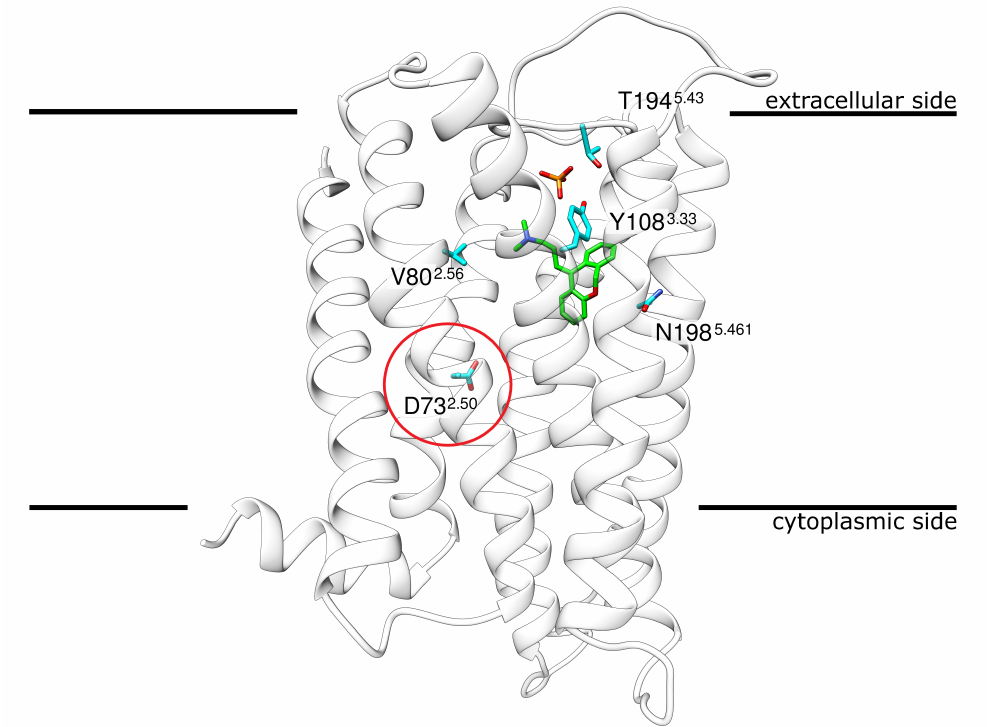
Figure 1. Structure of H 1 R in complex with the antagonist doxepin. H 1 R ribbon representation indicating the position of doxepin (green sticks) and phosphate (red/orange sticks) in the crystal structure. The encircled residue D73 2.50 marks the approximate location at which a Na + ion was found in other GCPRs. The four other residues shown in stick presentation represent the sites of mutation that were investigated in the present study.The membrane is schematically depicted as a black line. Coordinates from PDB entry 3RZE